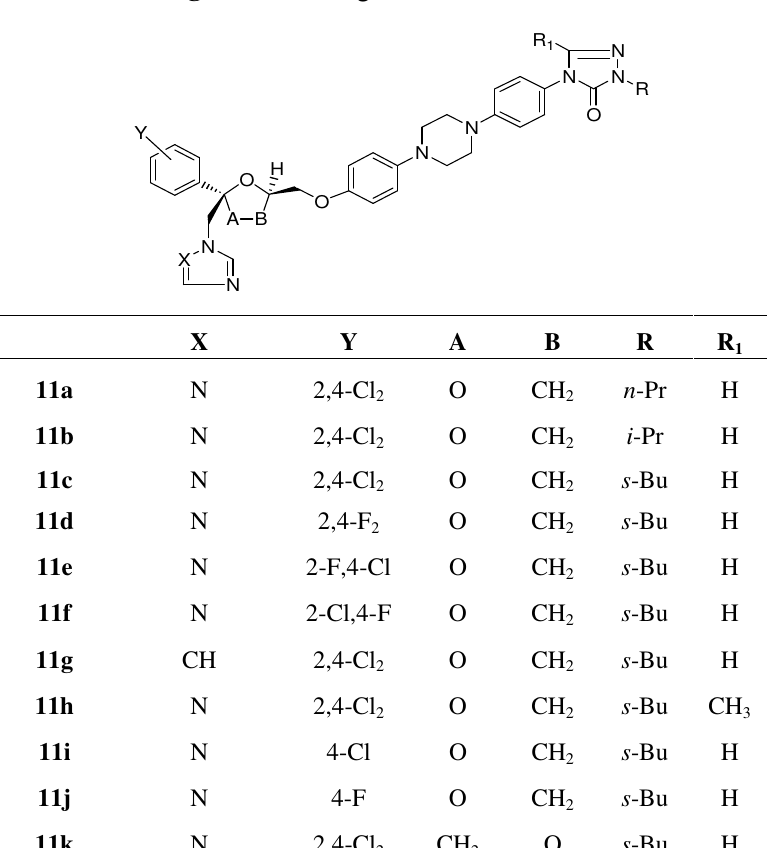
Figure 4. Analogues of